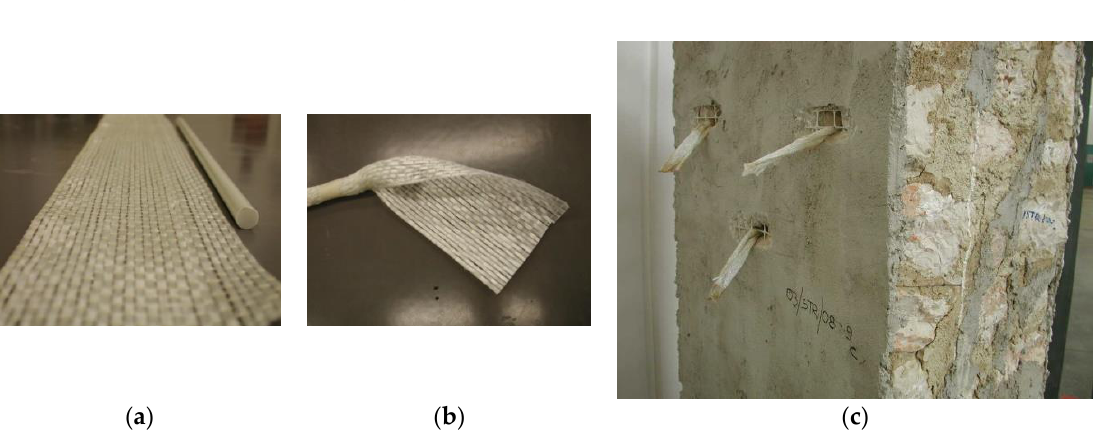
Figure 20. GFRP through-bars were used to connect the two polypropylene jackets. The GFRP bars were wrapped using a fiberglass sheet. This was epoxy-bonded to the polypropylene net: ( a ) GFRP bar and fiberglass sheet, ( b ) wrapping, and ( c ) insertion into the through-holes.